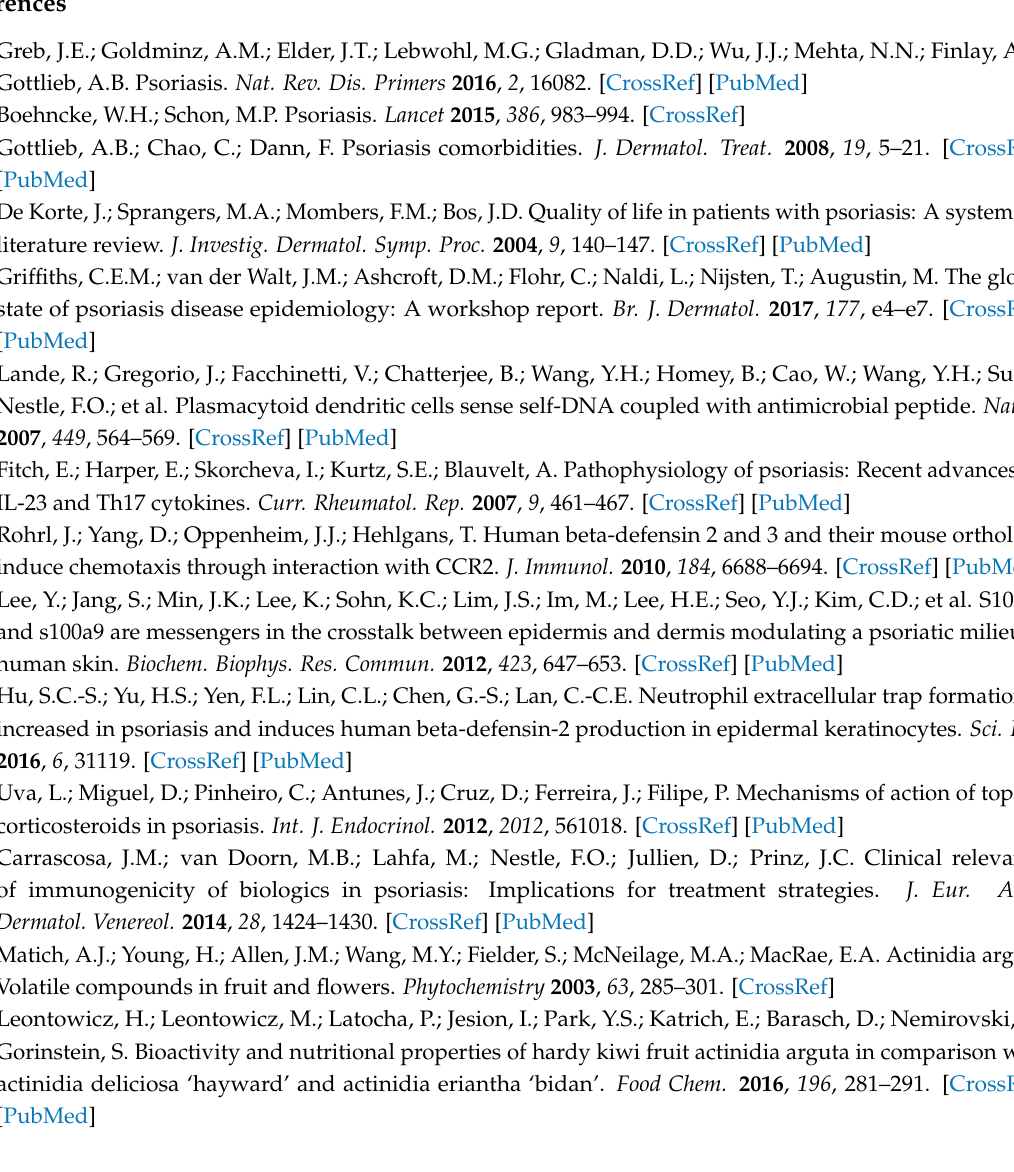
Figure S2: Topical administration of PG102 reduces IL-17A level in serum. After 6 days of IMQ treatment, serum from mice were collected were subjected to ELISA ( n = 6). The data are shown as the mean ± SEM. #### p < 0.0001 versus Control group; **** p < 0.0001 versus vehicle